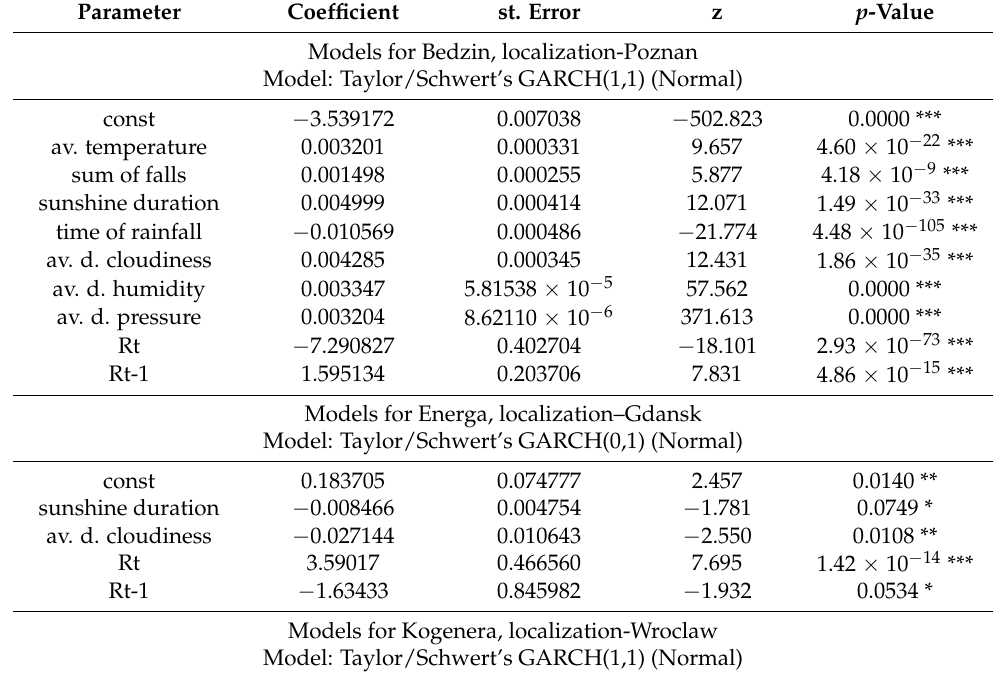
Table 1. Parameter values and a significance level of independent variables for individual companies (dependent variable: Change of trading